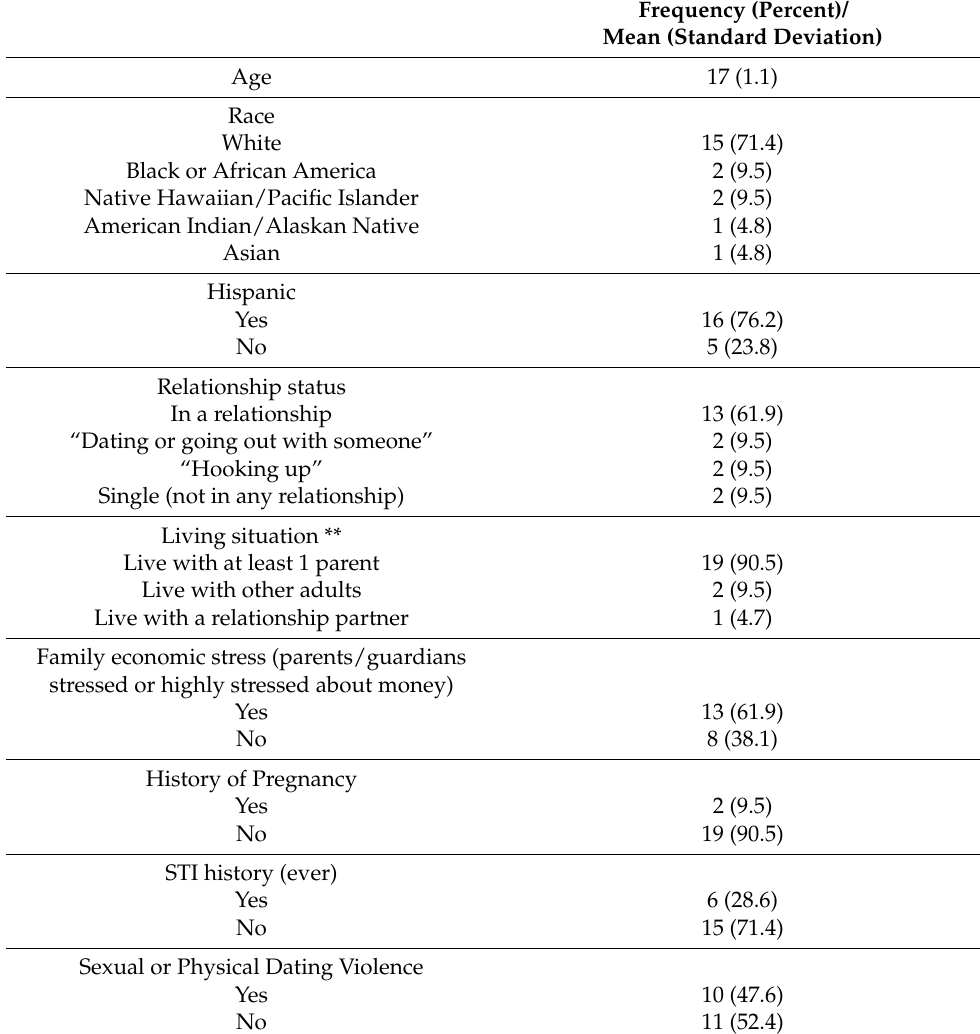
Table 1. Sample Characteristics of Adolescent Girls Participating in In-Depth Interviews ( n = 21) Sample Characteristics